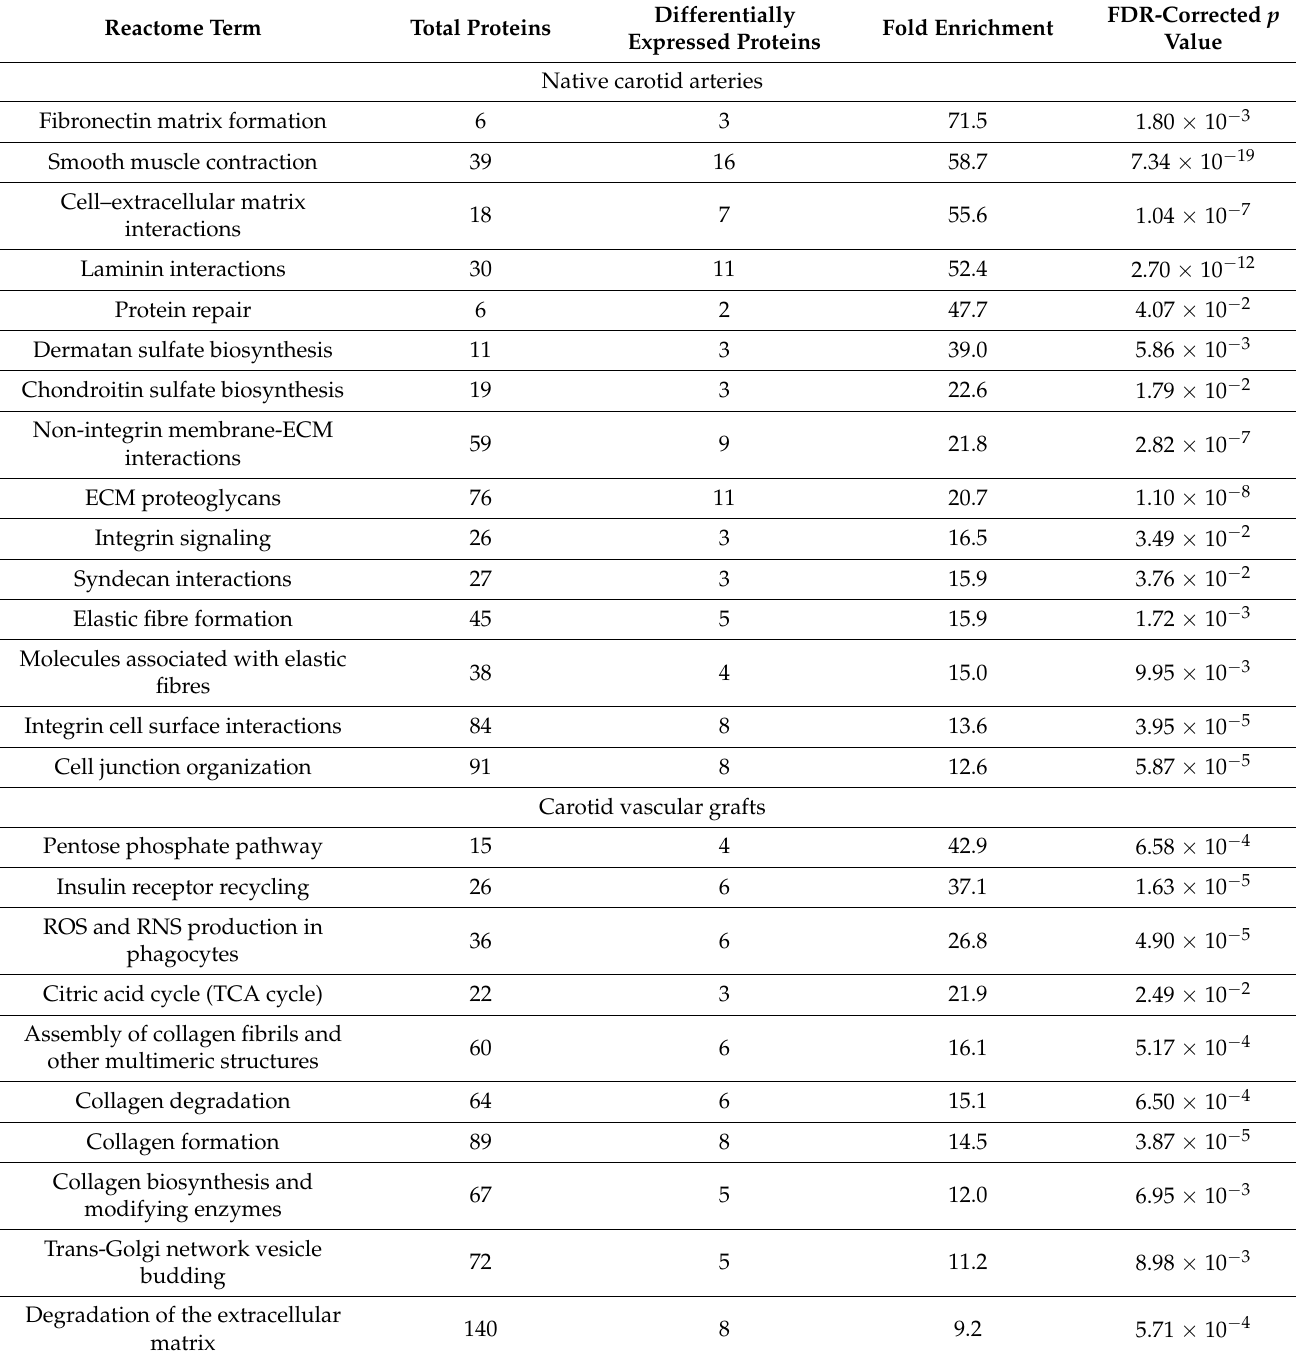
Table 7. Biological processes involving the proteins which are upregulated in either native carotid arteries or TEVGs (annotated according to the Reactome